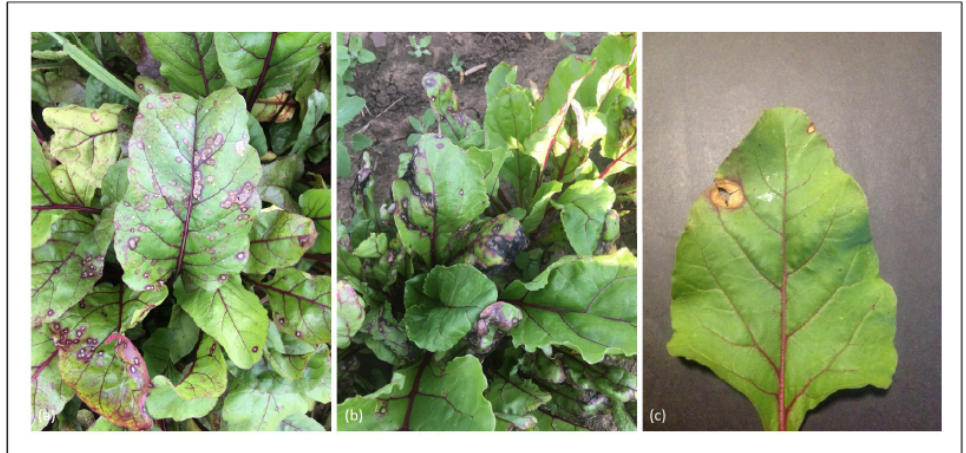
Figure 3. Foliar diseases commonly observed affecting table beet in New York: ( a ) Cercospora leaf spot caused by Cercospora beticola ; ( b ) Bacterial leaf spot caused by Pseudomonas syringae pv. aptata ; ( c ) Phoma leaf spot caused by Phoma betae .